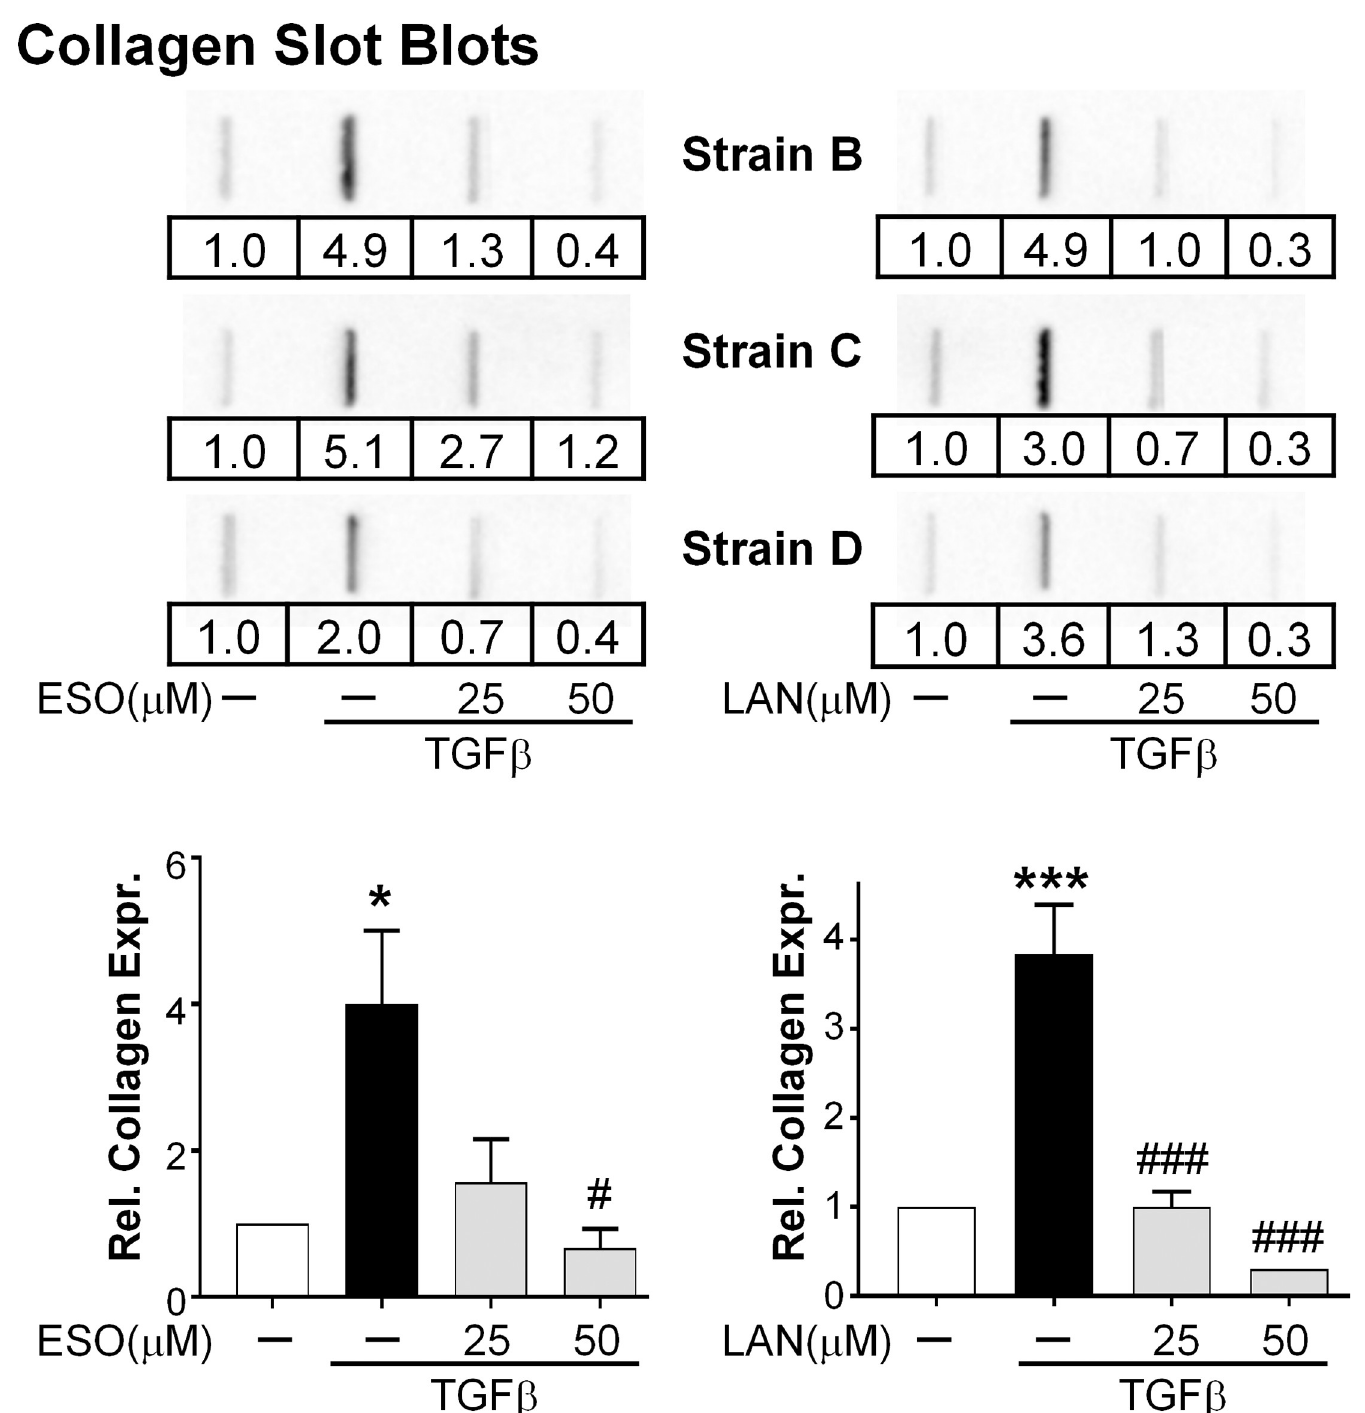
Fig 3. PPIs attenuate TGF β -induced collagen production. PPIs were added to TED orbital fibroblasts 24h before 1 ng/mL TGF β and then every 24h for the next 72h. Supernatants were collected at the end of the 72h and measured for collagen content using collagen slot blots. Data from three representative strains are shown. RE = relative expression; determined by setting each vehicle treated sample in the group of four bands to one. Graphs represent data from images of Strains B-D. N = 3. � = p < 0.05; ��� = p < 0.001; significantly different from vehicle treated control. # = p < 0.05; ### = p < 0.001; significantly different from TGF β alone. Statistics were measured by one-way ANOVA and Tukey’s post hoc